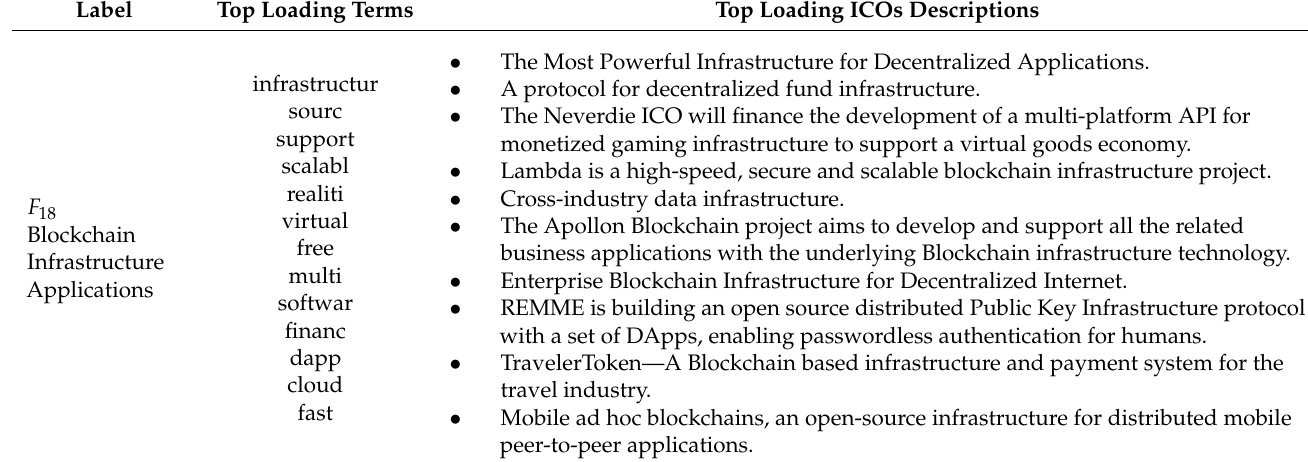
Table A18. Blockchain Infrastructure